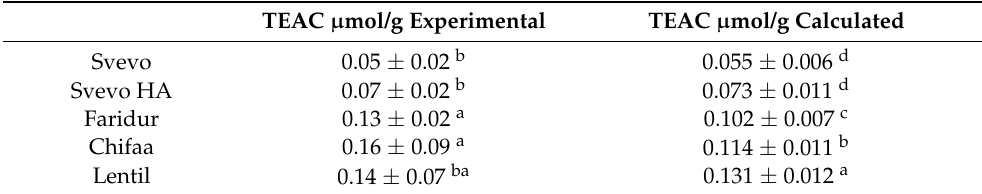
Table 5. Composition of experimental and calculated TEAC values of isoprenoid extracts for Svevo, Svevo-HA, Faridur, Chifaa and lentil. a–d Different letters within each column show significant differences ( p < 0.05).